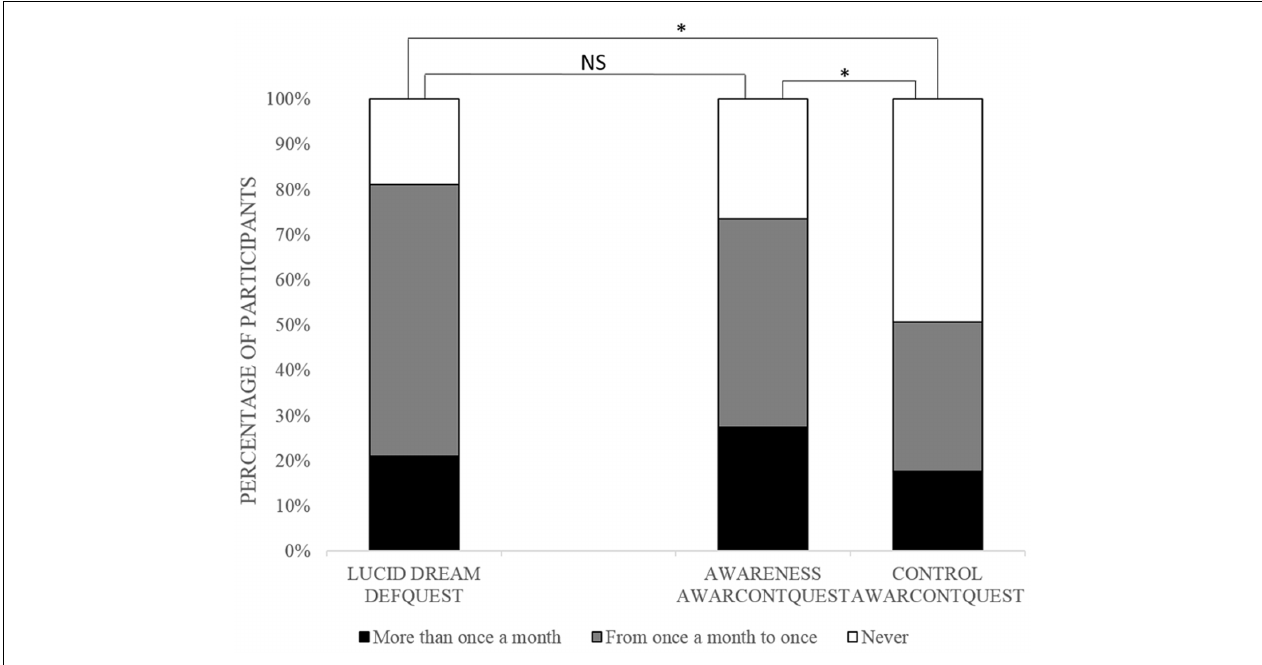
FIGURE 1 | Percentage of participants reporting LD in DefQuest ( N = 154) and awareness and control in AwareContQuest ( N = 153).